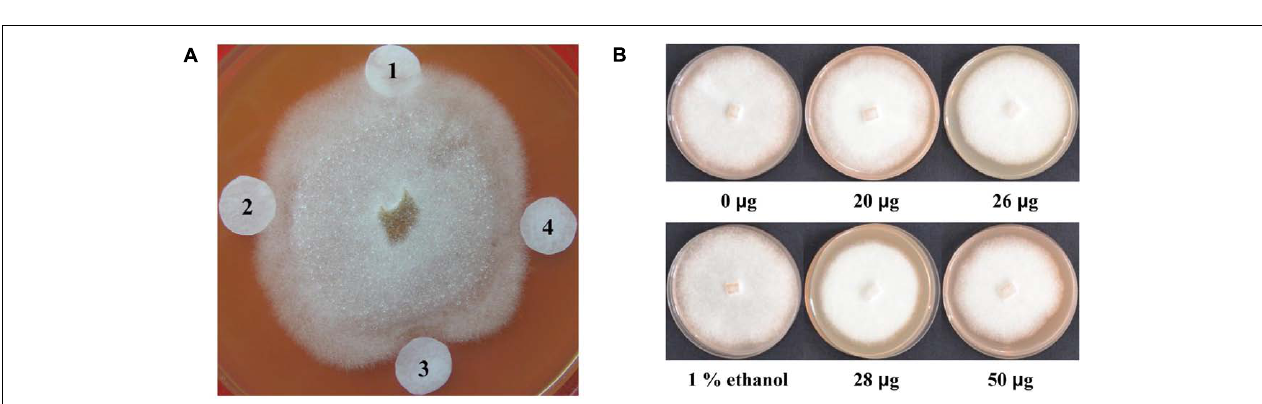
FIGURE 7 | Lignan and lignin content in GmDIR22 transgenic lines. (A) Lignan content. (B) Lignin content. Experiments were performed using three biological replicates with three technical replicates each. Bars indicated standard errors of the mean.